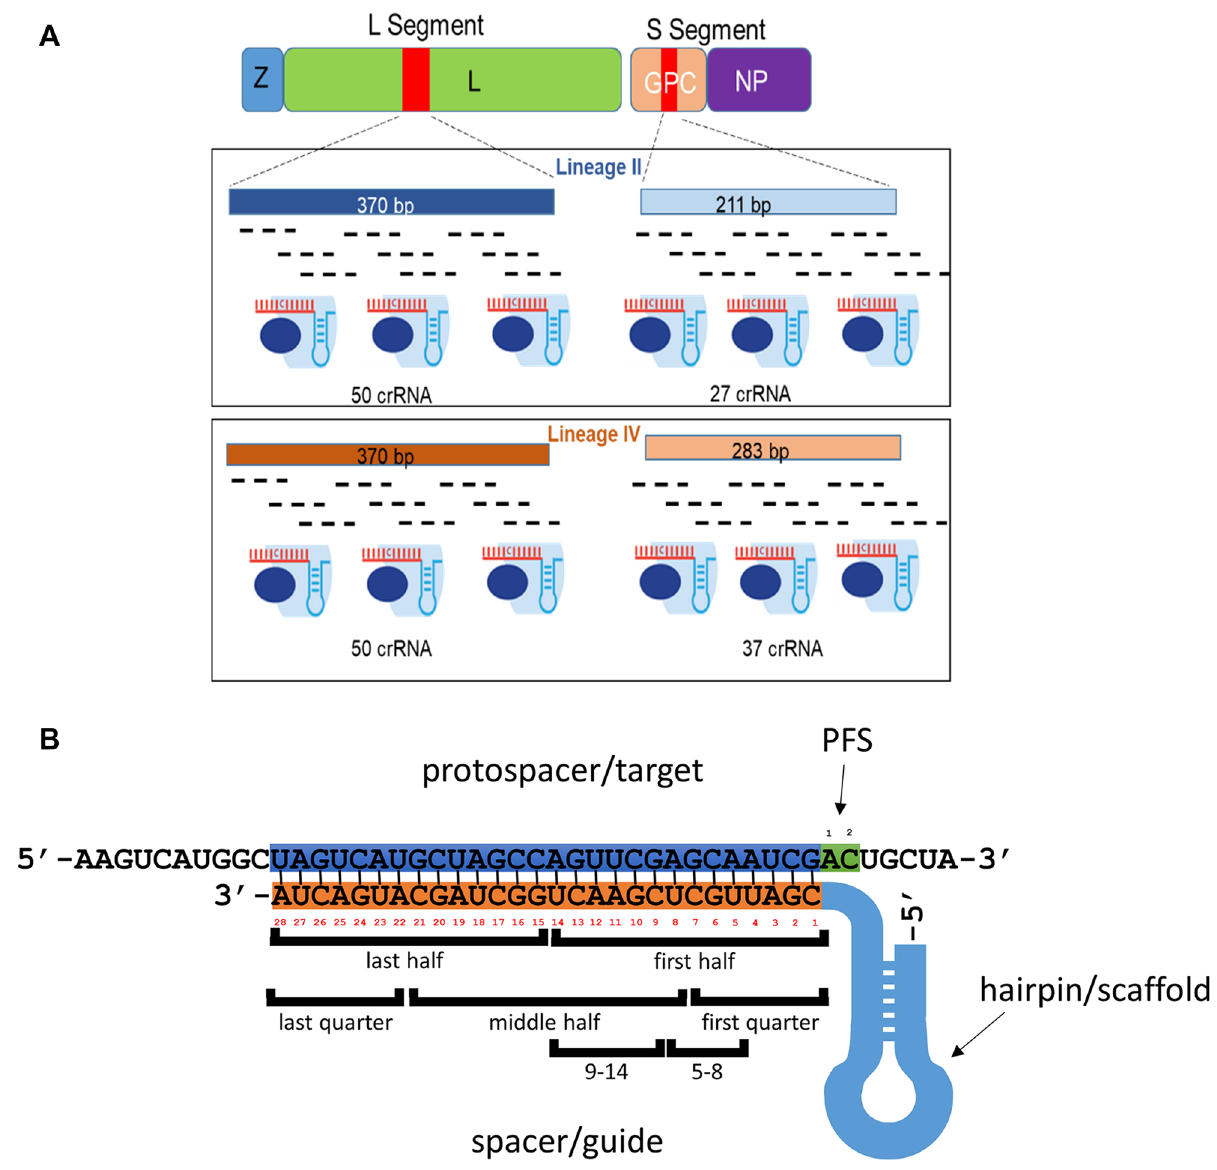
Figure 1. ( A ) Design of the crRNAs targeting conserved regions of LASV L and GPC genes. Overview of the LASV crRNA design strategy. Conserved regions of the L (370 bp) and GPC (211 bp or 283 bp) were selected and consensus sequences for lineage II or lineage IV were constructed (supplementary Table 2 and supplementary materials: lineage II target sequences and lineage IV target sequences). The degenerate spacer sequences of the crRNAs were designed by tiling the 28nt sequences across the consensus target sequences. ( B ) Structure of the Cas13a crRNA and target. Protospacer (target) sequence (top) – blue shading: part of the target complementary to the spacer sequence, green shading: protospacer flanking sites (PFS); crRNA: orange shading: spacer sequence numbered (1–28) in 5 ′ –3 ′ direction, light blue shading – hairpin/constant part of the crRNA. Location of features defined in RuleFit model are indicated below the spacer